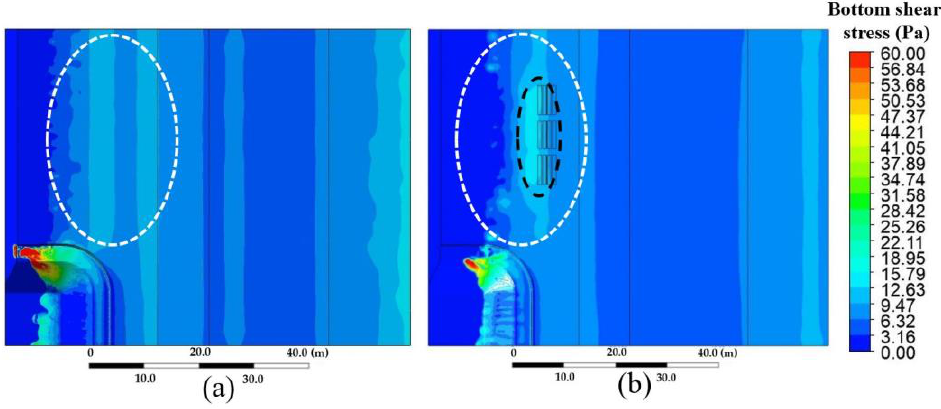
Figure 12. The bottom shear stress of ( a ) P0 and ( b ) P1/15°